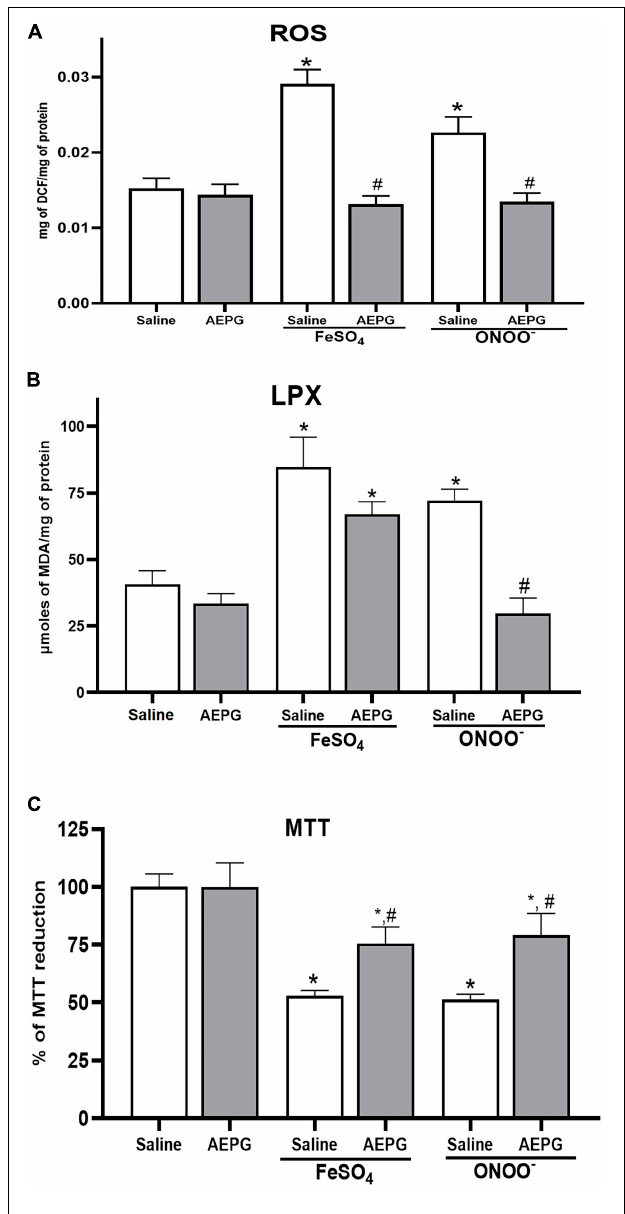
FIGURE 2 | Effect of AEPG, on reactive oxygen species (ROS) (A) , Lipid peroxidation (LPX) (B) production and cellular dysfunction (MTT) (C) induced by FeSO 4 (10 µ M) and peroxynitrite (ONOO − ; 50 µ M) in brain homogenates from ovariectomized rats. Data are shown as mean ± S.E.M. of five experiments per group (each experiment corresponding to one rat). One-Way Anova test followed by * p < 0.05 vs control-group; # versus vehicle (saline-group) for each